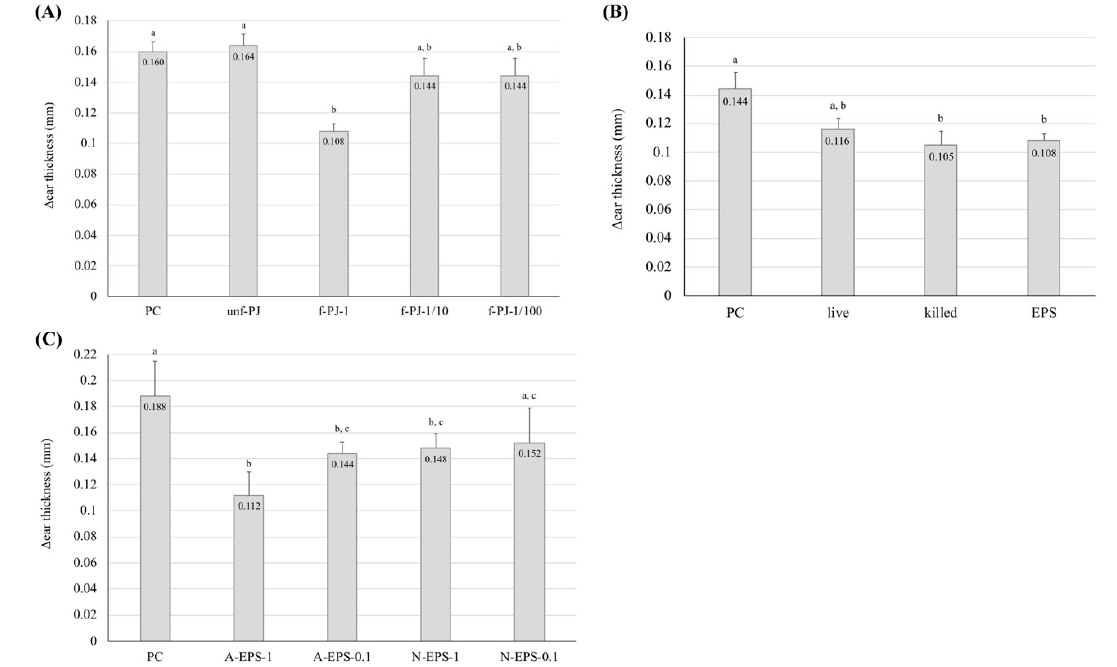
Figure 1. Observed improvement in the PiCl-induced ear inflammation by oral administration of ( A ) IJH-SONE68-fermented pineapple juice, ( B ) the cell suspension or EPS fraction, and ( C ) purified neutral and acidic EPSs. Ear thickness was measured just before and 24 h after the challenge.